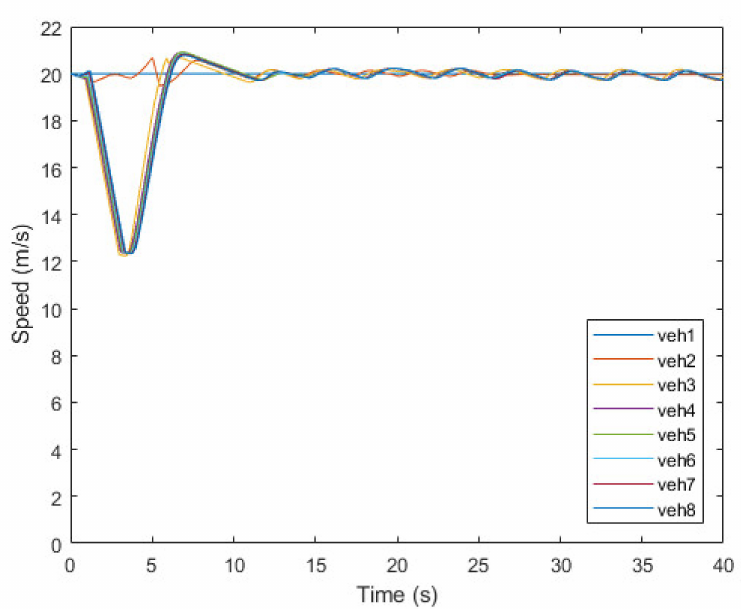
Figure 10. Speed of